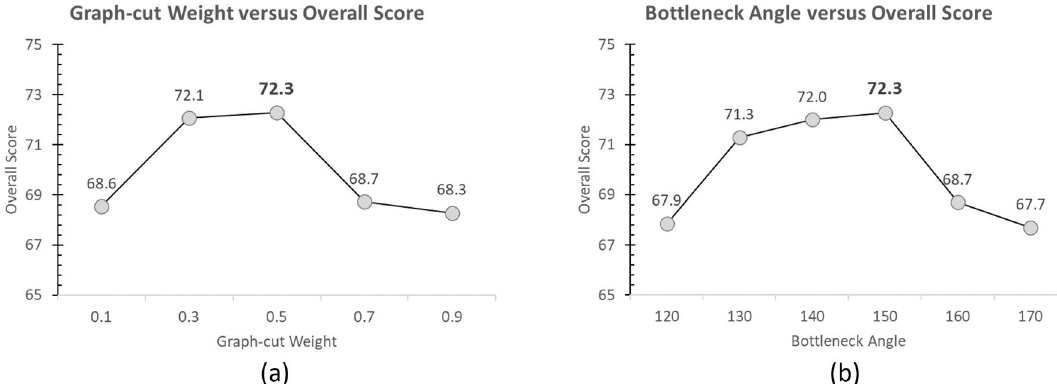
Figure 10. ( a ) Relationship between graph-cut weight and over score, showing the highest value at 0.5. ( b ) Relationship between bottleneck angle and over score, showing the highest value at 150.